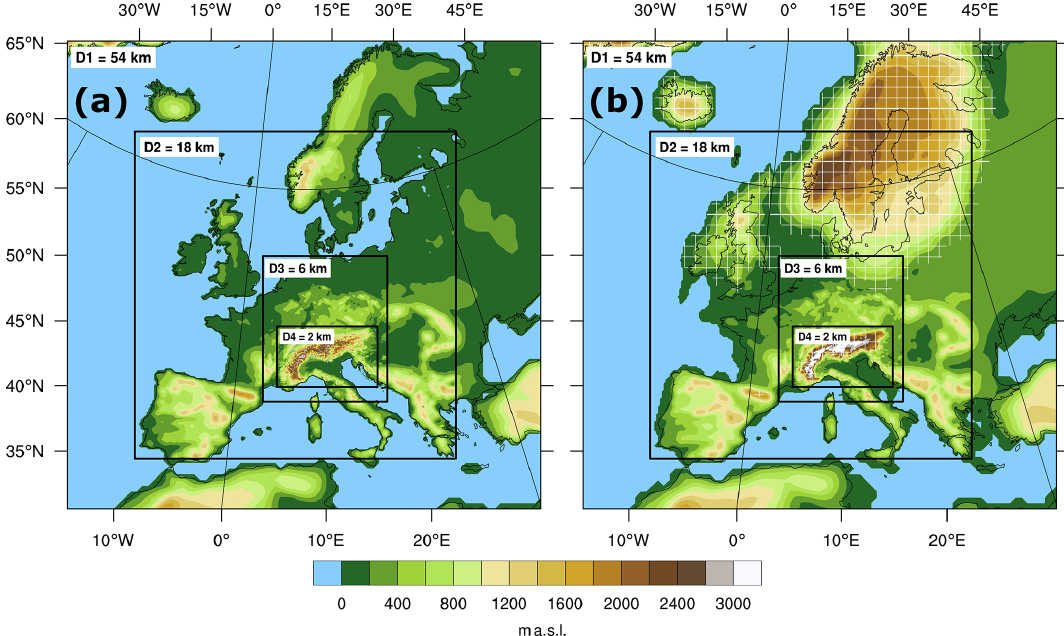
Figure 1. Domains and topography used by WRF. Panel (a) represents the four domains at 54, 18, 6 and 2km horizontal resolution, and the shading indicates present-day topography; (b) as panel (a) but for the LGM topography, crosshatched areas are covered by glaciers.